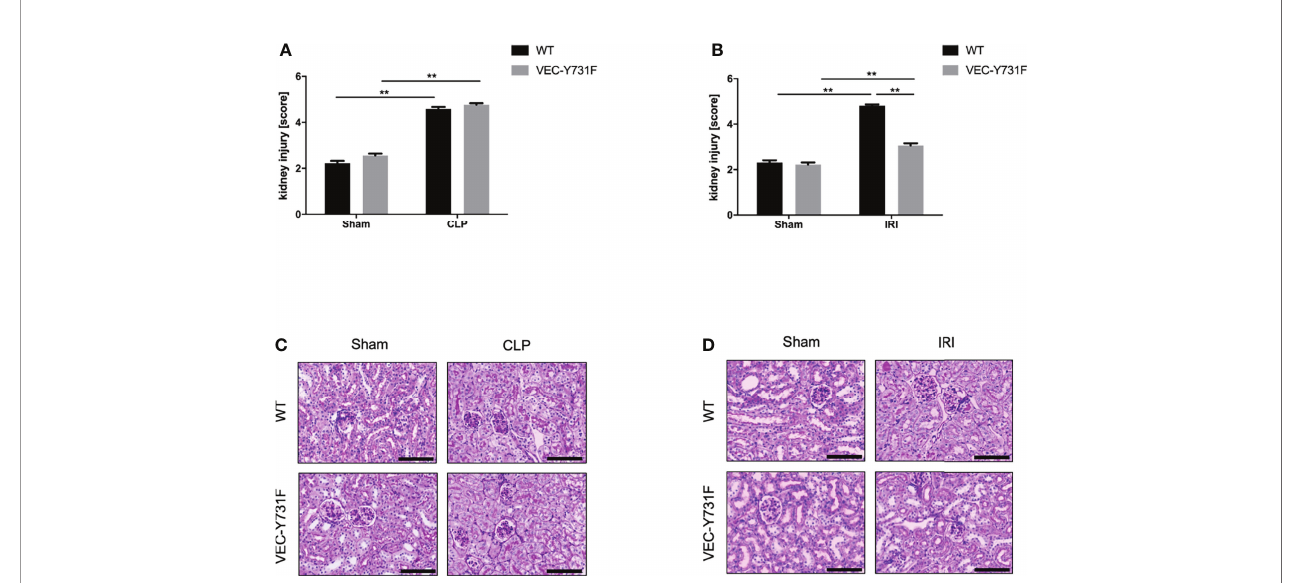
FIGURE 2 | Impaired neutrophil recruitment decreases renal tissue injury and cell apoptosis only in IRI- but not CLP-induced AKI. AKI in WT and VEC-Y731F mice was induced either by CLP or IRI. 24 hours after AKI-induction renal cortical tissue sections were excised, fi xed in formaldehyde, embedded in paraf fi n and processed for H&E staining. The histological analysis was performed from at least 25 high-power fi elds per kidney from WT and VEC-Y731F mice after CLP (A) or IRI (B) surgery and the kidney injury score was calculated. Exemplary histological images of H&E staining from WT and VEC-Y731F mice after CLP (C) or IRI (D) surgery (n = 3). Data are mean ± SEM. **p < 0.01. Scale bar: 100